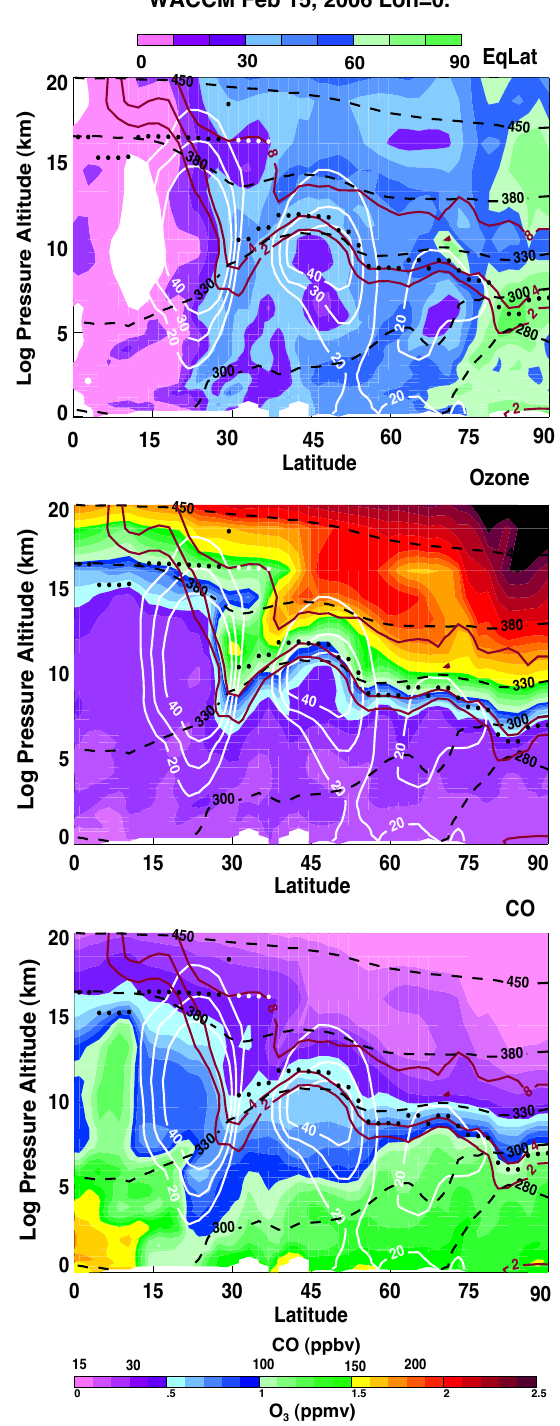
Fig. 8. WACCM NH meridional cross-sections of EqLat (top), Ozone (middle) and CO (bottom) for 15 February 2006 along 0 ◦ longitude. In each panel, selected meteorological variables are also shown, including isentropes (black dash lines), wind speed (white lines), PV (red lines) and the thermal tropopause (black dots). White colour-filled areas of EqLat represent negative